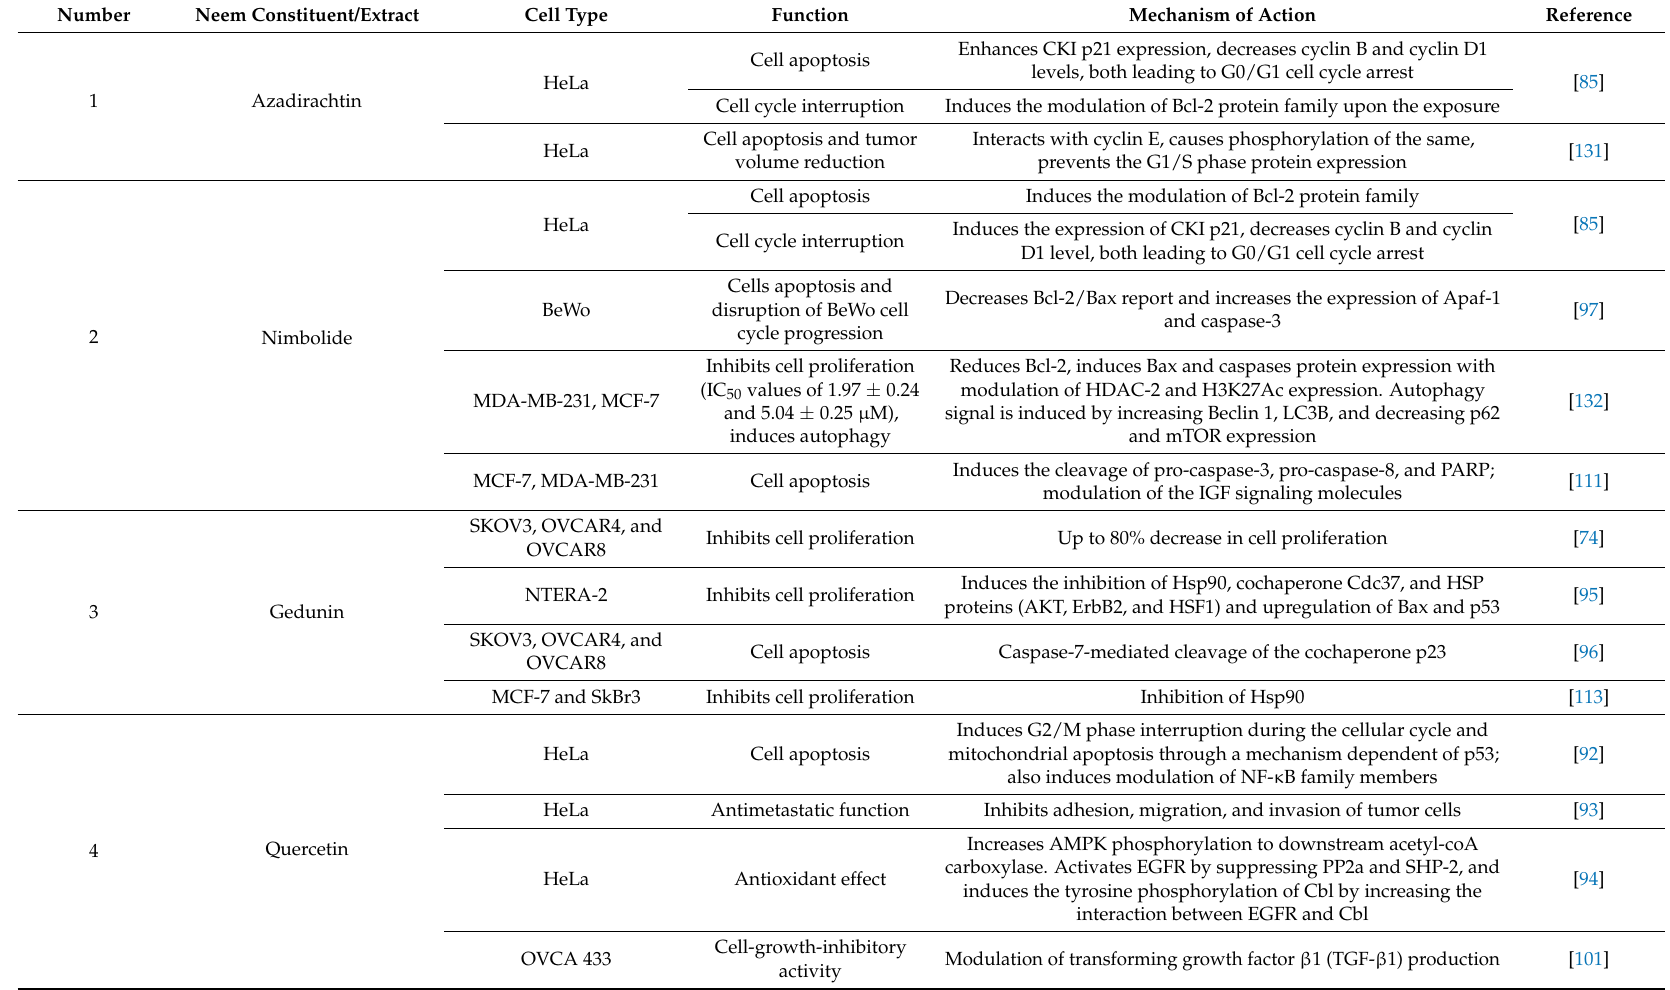
Table 1. Comparative anticarcinogenic properties of neem fractions and compounds in gynecological cancers based on in vitro